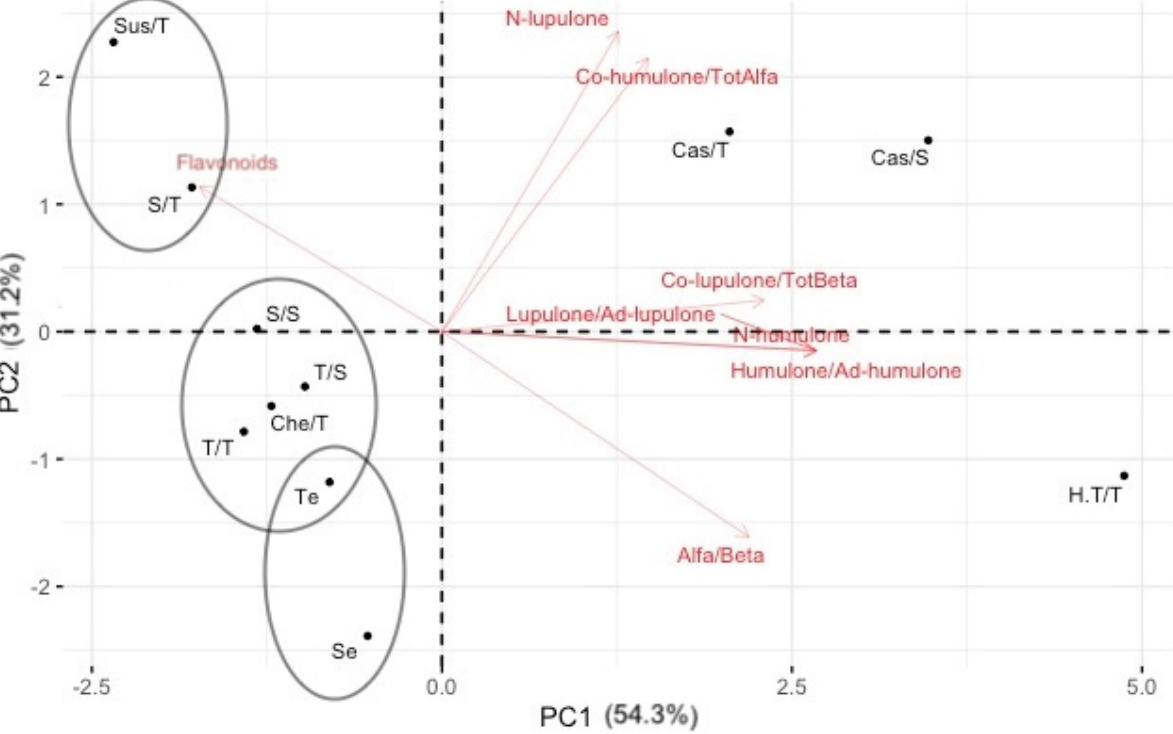
Figure 1. Biplot of the Principal Component Analysis applied to quantitative data of all hop samples for the first two principal components.